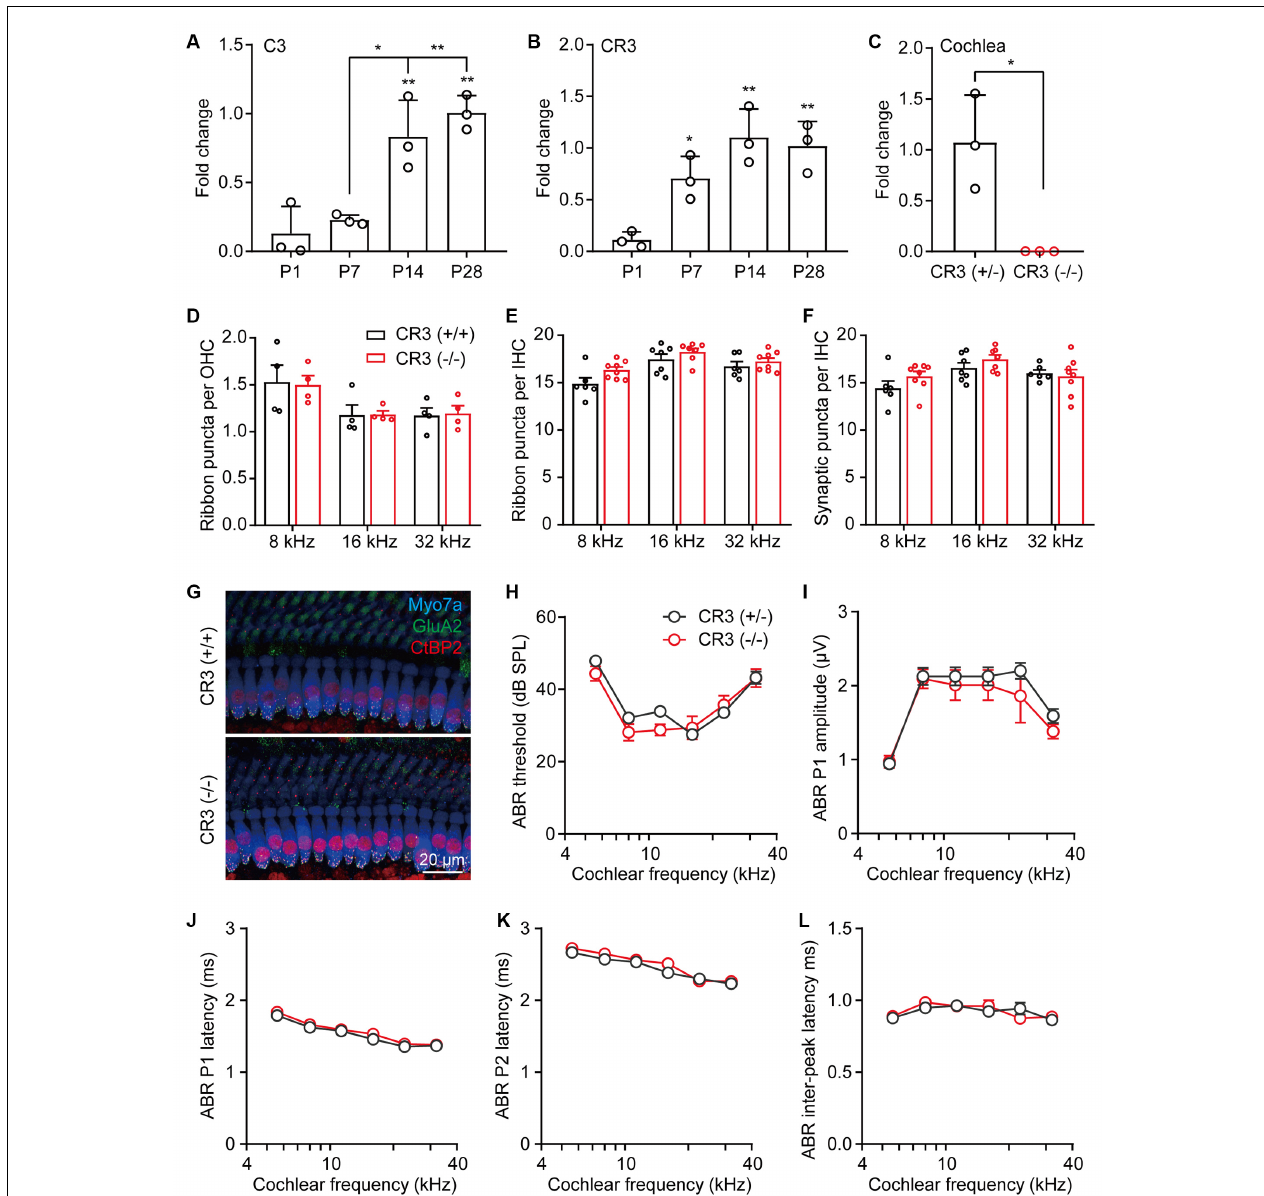
FIGURE 3 | Complement receptor CR3 was not required for pruning of cochlear ribbon synapses and auditory function. (A,B) RT-qPCR analyses of (A) C3 or (B) CR3 expression in P1, P7, P14, and P28 cochleae. N = 3, error bars represent mean ± SD. * p < 0.05 and ** p < 0.01 by one-way ANOVA. (C) RT-qPCR analyses of CR3 knockout in the cochlea. N = 3, error bars represent mean ± SD. * p < 0.05 by unpaired Student’s t -test. (D,E) Quantitative analyses of OHC (D) and IHC (E) synaptic ribbons in P21 wildtype and CR3 knockout cochlea. (F) Quantitative analyses of putative IHC ribbon synapses (colocalized GluA2 and CtBP2 signals) in P21 wildtype and CR3 knockout cochlea. N = 4–8, error bars represent mean ± SEM. (G) Representative confocal images of P21 wildtype and CR3 knockout cochlea at 16 kHz. Myo7a, hair cells; GluA2, postsynaptic receptors, and CtBP2, pre-synaptic ribbons. (H–L) ABR tests of P21 wildtype and CR3 knockout mice. (H) ABR thresholds, (I) ABR P1 amplitudes, (J) ABR P1 latencies, (K) ABR P2 latencies, and (L) ABR P1-P2 inter-peak latencies. ABR amplitudes and latencies were analyzed at 80 dB SPL. N = 8 (CR3 KO) or 14 (wildtype), error bars represent mean ±